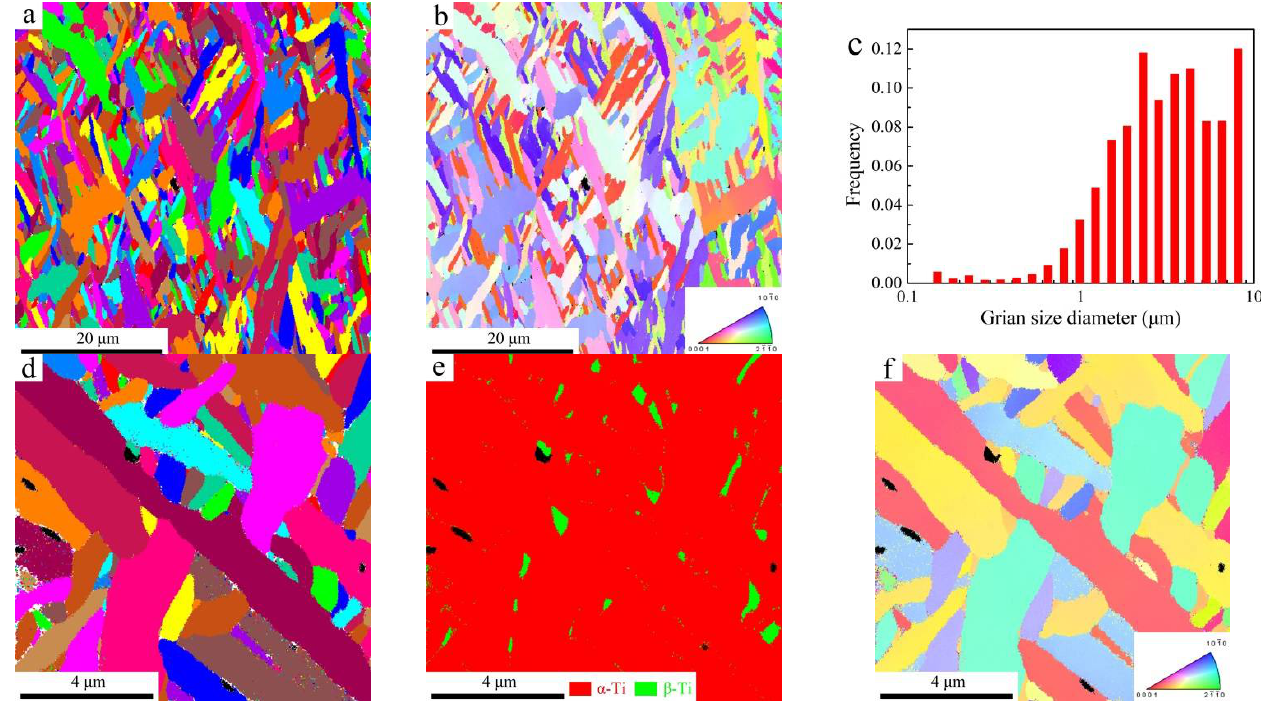
Figure 5. PBF-EB AM Ti6Al4V alloy with only the linear scanning strategy (sample A): ( a ) Grain size and ( b ) IPF images at low magnification; ( c ) grain size, ( d ) phase map, and ( e ) IPF figures at high magnification. The color of the inset figure in ( b , f ) represents grains orientation.